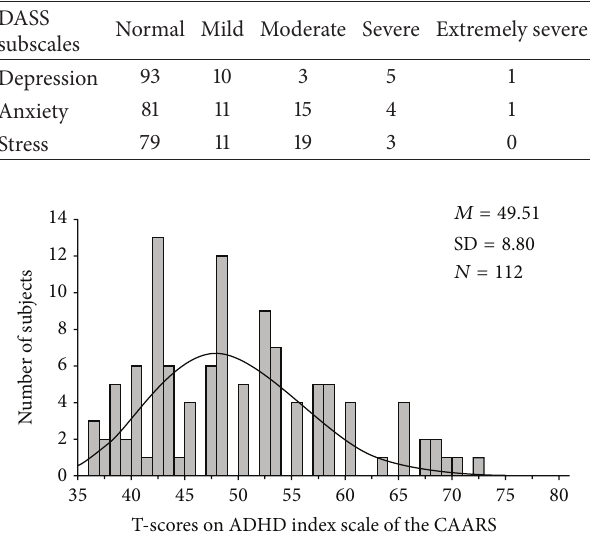
Figure 2: The distribution of T-scores on ADHD index subscale of the